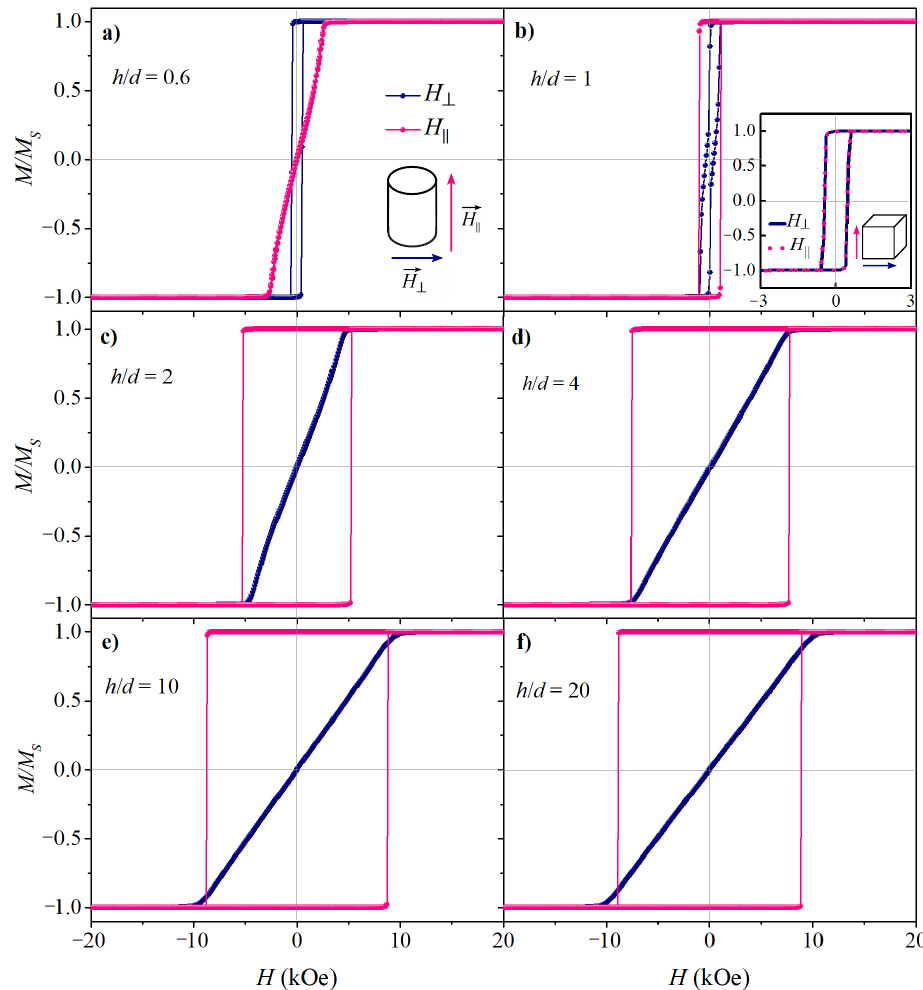
Figure 2. Calculated hysteresis loops of the isolated iron cylindrical nanostructures with a magnetic field applied parallel (pink) and perpendicular (dark blue) to the direction determined by the axis of the nanoobjects ( h parameter). The following values of aspect ratio h / d were adopted: 0.6 ( a ), 1 ( b ) (inset: M ( H ) loops for Fe nanostructure with a cube shape), 2 ( c ), 4 ( d ), 10 ( e ) and 20 ( f